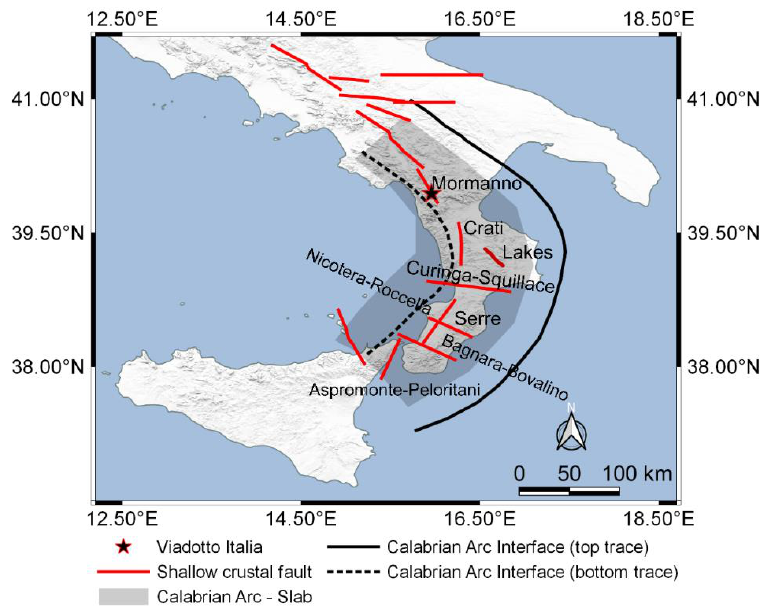
Figure 9. Shallow crustal and subduction zone seismic sources in the Calabrian Arc area used for the PSHA application of this study (source geometries and information from Zimmaro and Stewart [23]).